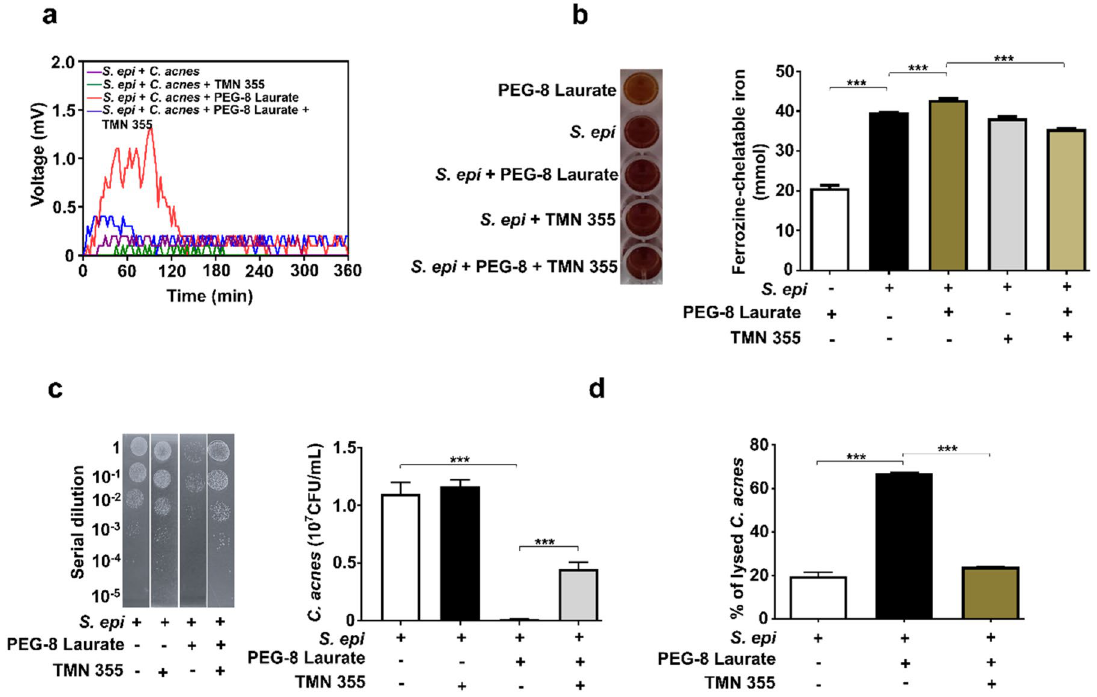
Figure 3. Electrons produced by S. epidermidis plus PEG-8 Laurate caused lysis of C. acnes . ( a ) The voltage differences (mV) which were measured in conditions of anodes pipetted with media containing S. epidermidis ( S. epi ) pretreated with/without TMN 355 in the presence or absence of PEG-8 Laurate, and C. acnes were placed in a petri dish containing anode, cathode and PEM. ( b ) Electrons produced by S. epidermidis plus PEG-8 Laurate were detected using a ferrozine assay. S. epidermidis pretreated with/without TMN 355 was added into TSB media supplemented with ferrozine and ferric ammonium citrate in the presence or absence of PEG-8 Laurate. Addition of PEG-8 Laurate alone into TSB media supplemented with ferrozine and ferric ammonium citrate served as a control. The formation (dark brown) of ferrozine-chelatable irons (mM) was quantified by OD 562 measurements. ( c ) C. acnes in anodes was collected and serially diluted (1 : 10 0 –1 : 10 5 ) before spotting on a selective agar plate consisting of rich media plus furazolidone (10 µg/mL). The graph represents the CFU/mL of C. acnes from three separate experiments. ( d ) The percentage (%) of lysed C. acnes assayed by the uptake of crystal violet was displayed after response of C. acnes in cathodes to anodes pipetted with S. epidermidis or TMN 355-pretreated S. epidermidis in the presence or absence of PEG-8 Laurate. Data are represented as mean ± SD (n = 3 each group). *** P < 0.001, (two-tailed